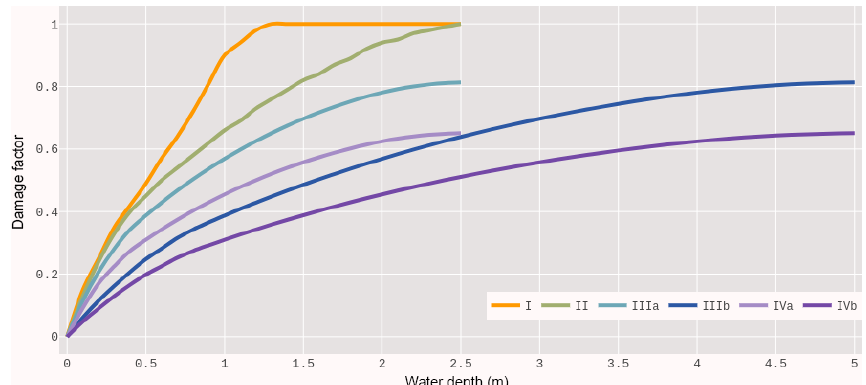
Figure 2. Stage-damage curves for four building-material-based vulnerability classes. For class III and IV the one- and two-floor curve are denoted by (a) and (b) . Table 2. Construction types of the ImageCat building exposure data with their respective flood vulnerability class. Type Description